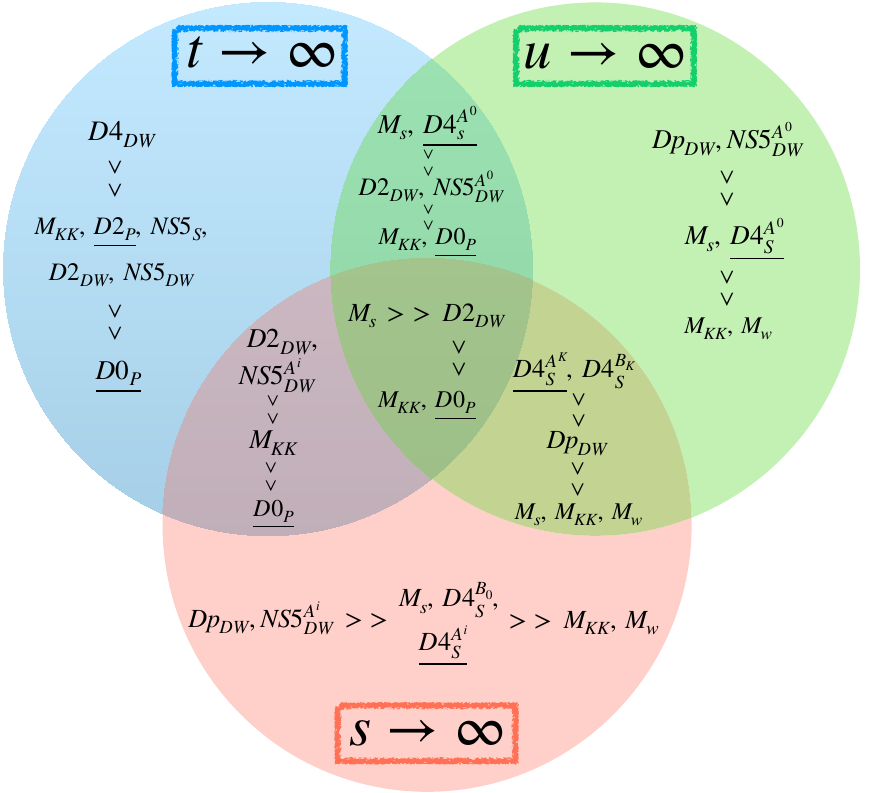
Figure 4. Spectra of towers of lightest particles and branes for different infinite limits in moduli Z . The subindices P , S and DW indicate whether the object is a particle, space, for the T 6 / Z 2 (cid:31) 2 × a string or a domain wall and the underlined ones are projected out by the orientifold action.